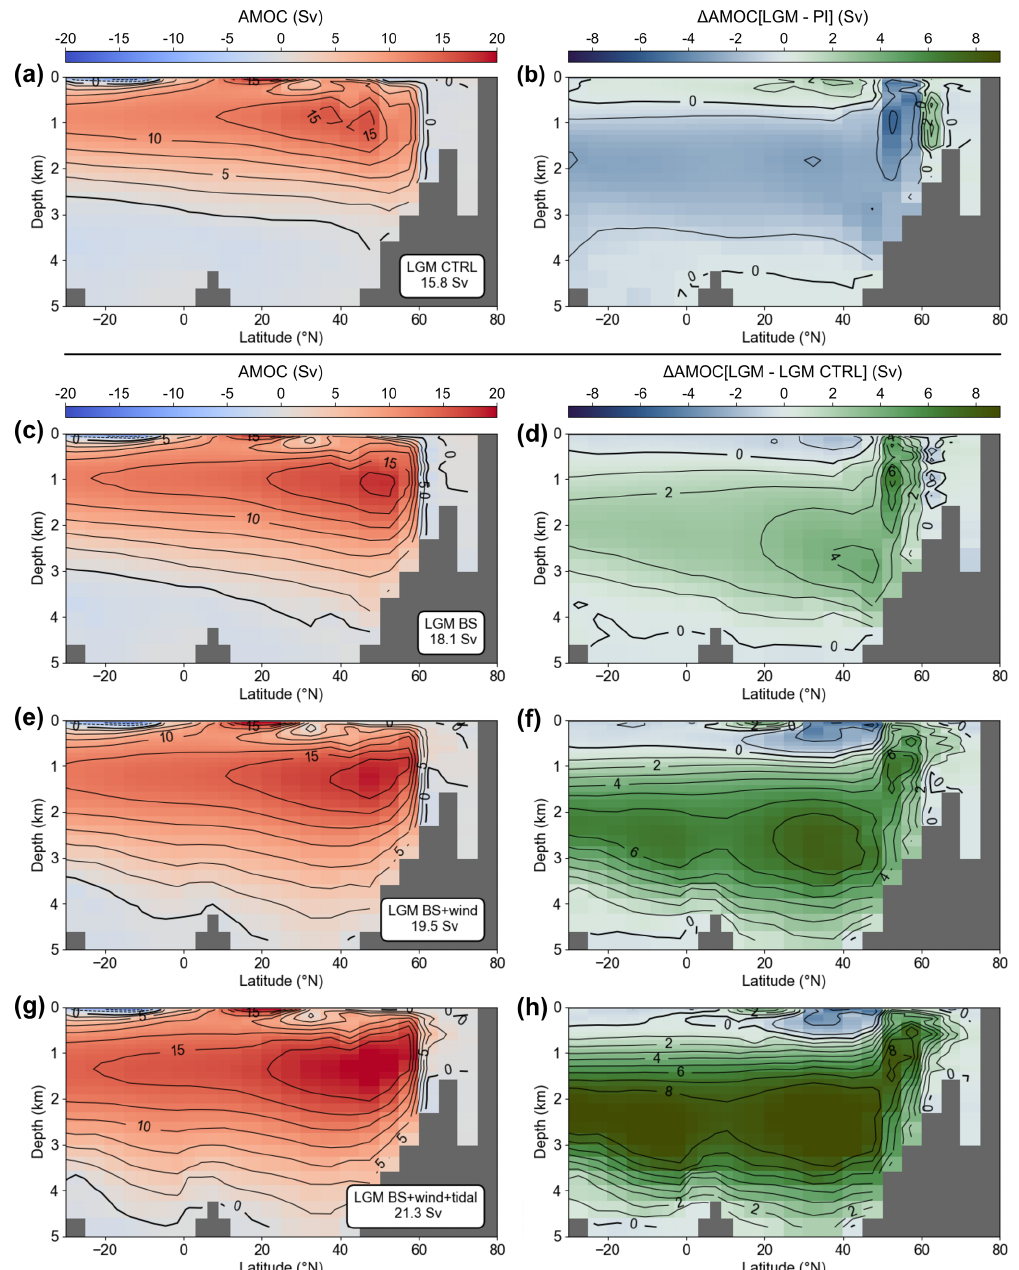
Figure 3. (a) Zonally integrated overturning stream function of LGM_CTRL (AMOC = 15 . 8Sv) and (b) difference to the PI_CTRL depicted in Fig. 2a. (c, d) LGM with closed Bering Strait (18.1Sv) and difference to LGM_CTRL depicted in panel (a) . (e, f) LGM with closed Bering Strait and LGM wind stress (19.5Sv). (g, h) LGM with closed Bering Strait, LGM wind stress, and increased diapycnal diffusivity due to lower sea level (21.3Sv). See Sect. 3 and Table 1 for details on